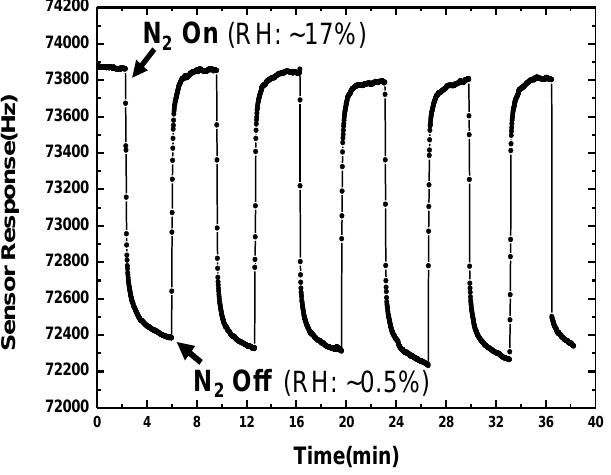
Figure 7. Frequency shift as a function of time, while the RH was changing in the range of 0%–17% (adsorption) and 17%–0%